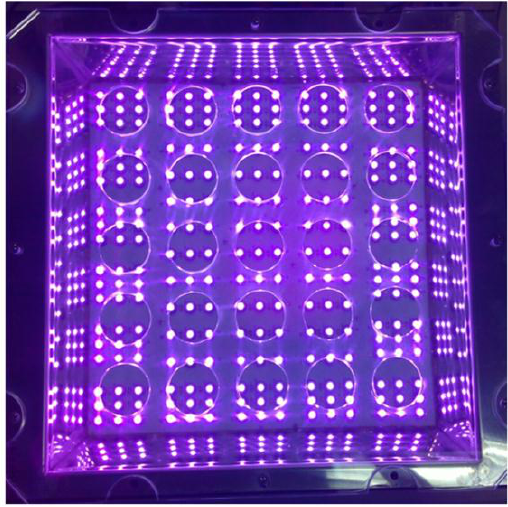
Figure 29. The experimental model of LED power adjustment type 2 in the actual process.